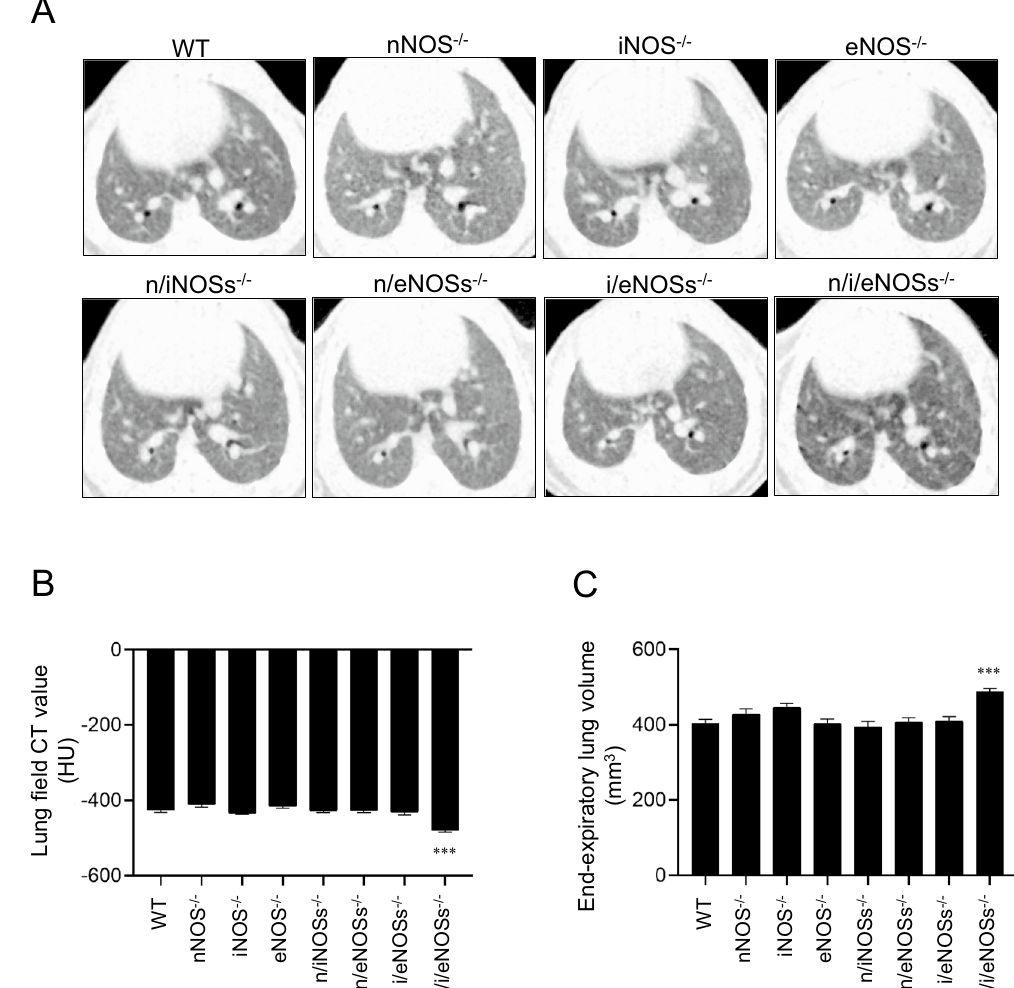
Figure 2. Micro CT analysis of the lungs. Experiments were performed in 8-week-old male WT and single, double, and triple NOSs −/− mice (n = 9–10). (A) Micro CT images. (B) CT value in the lung field. (C) End- expiratory lung volume estimated by micro CT images. *** P < 0.001 vs. WT